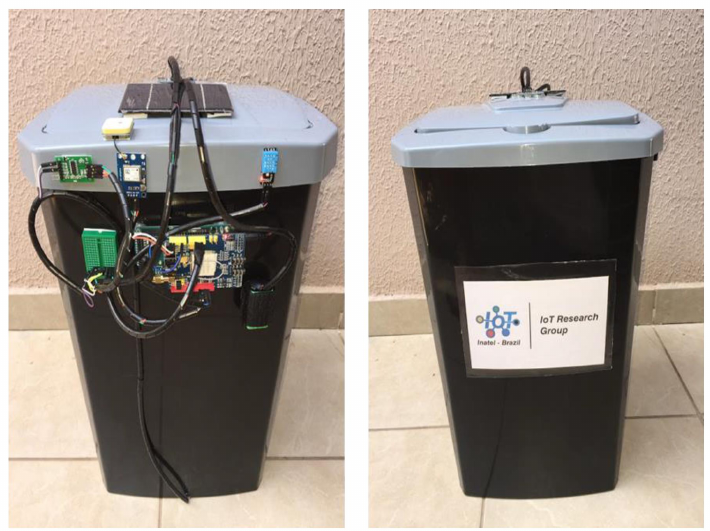
Figure 8. Front and back view of the My Waste Bin, an IoT smart waste container, enabling real-time GPS tracking and weight monitoring